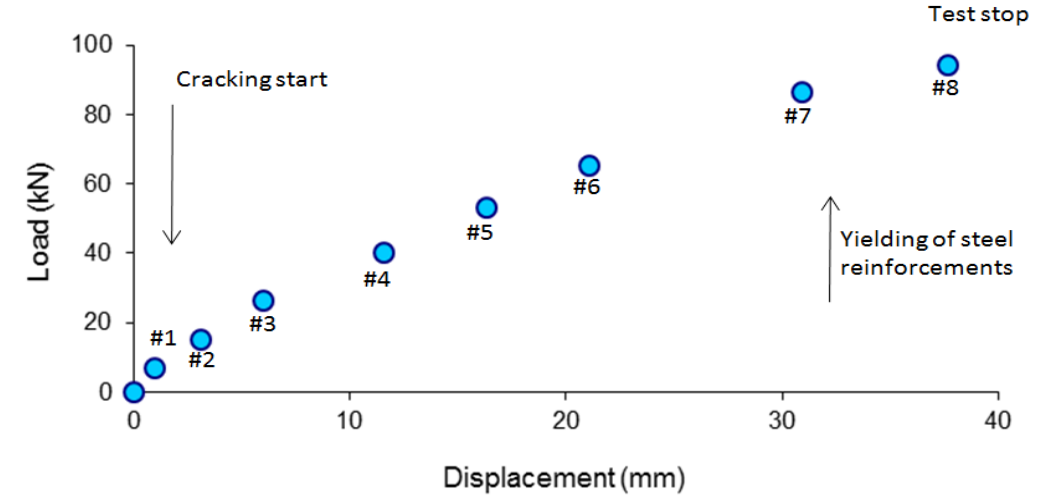
Figure 4. Load versus mid-span deflection at the different load steps, from #0 to #8.